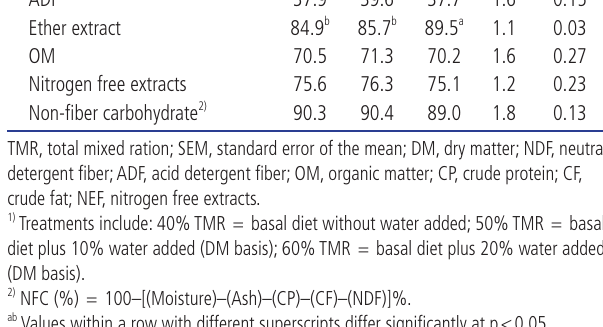
Table 4. Effects of adding water to TMR on fresh water intake and nutrient digestibility in ewes during hot and humid conditions